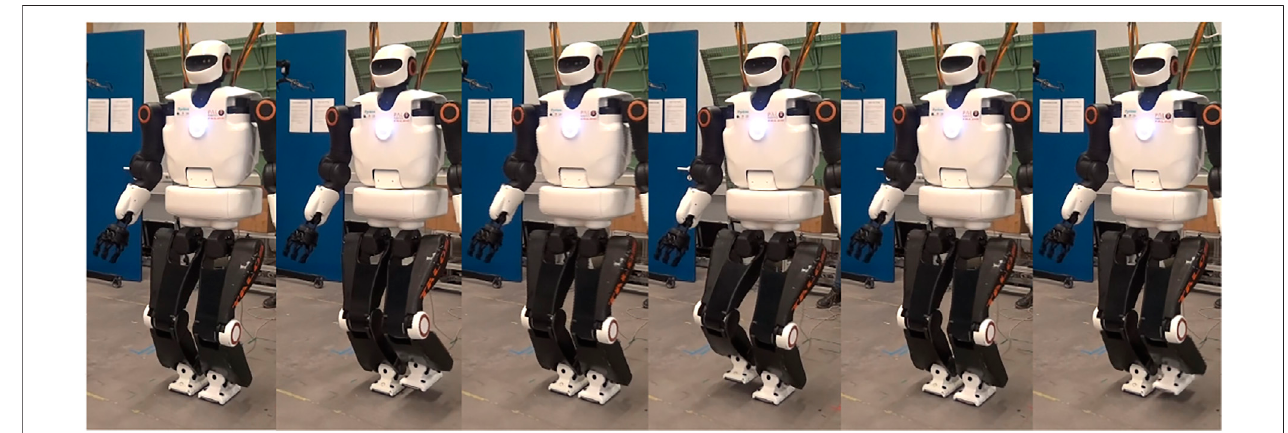
FIGURE 11 | Experiments — on-spot walking with the TALOS